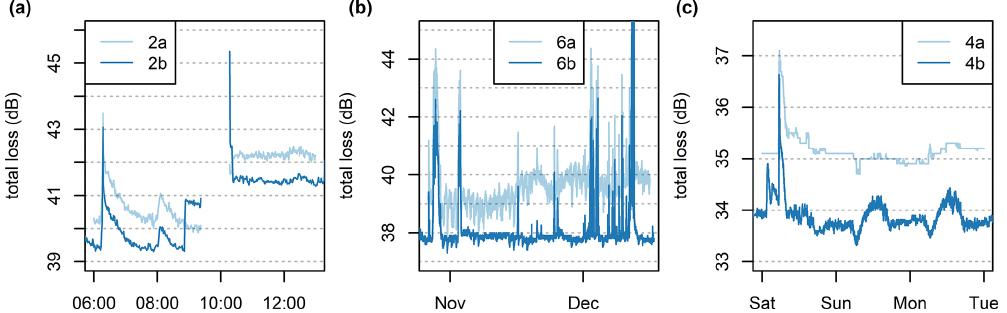
Figure B1. Demonstration of hardware-related artifacts: (a) sudden change in the baseline of CML 2, (b) baseline drift of sublink 6a, and (c) degraded resolution of sublink